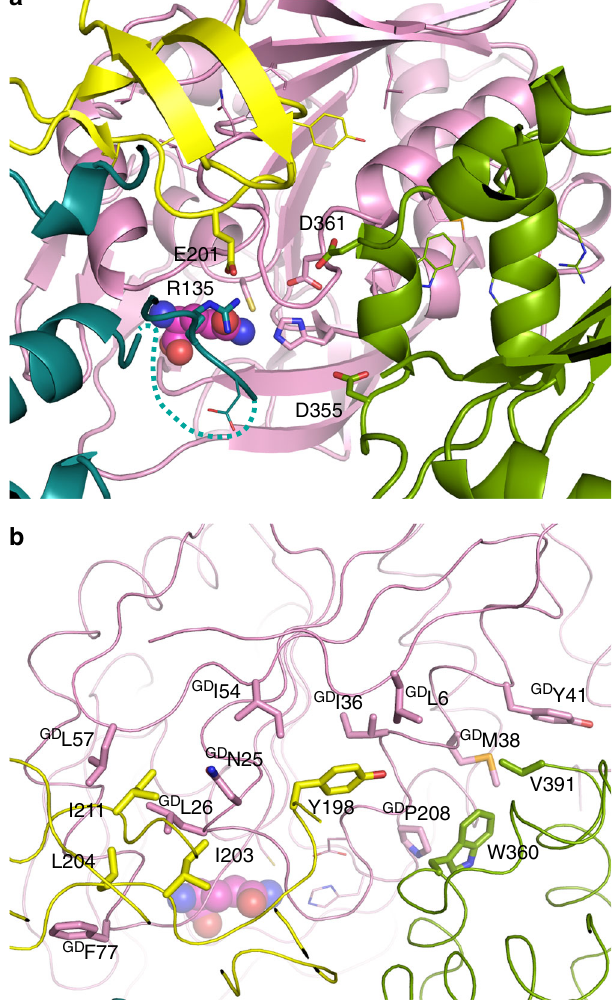
Fig. 7 Interface of the MurT/GatD complex. a View of the negative gate of MurT facing the GatD active site seen from the MurT active site. MurT residues bordering the putative channel for the transfer of ammonia are labeled and shown as atom-colored sticks. The GD Cys107- GD His206- GD Asp32 residues of the GatD active site are shown as sticks without labels. Other residues involved in the MurT/GatD interface are shown as atom-colored lines. The dashed line indicate the 137 – 143 loop missing from the structure of MurT. L-glutamine is shown as spheres. b View of the MurT/GatD interface with the residues involved in hydrophobic interactions labeled and shown as atom-colored sticks. The main chains of the proteins are shown as loops and the residues involved in electrostatic interactions are shown in atom-colored